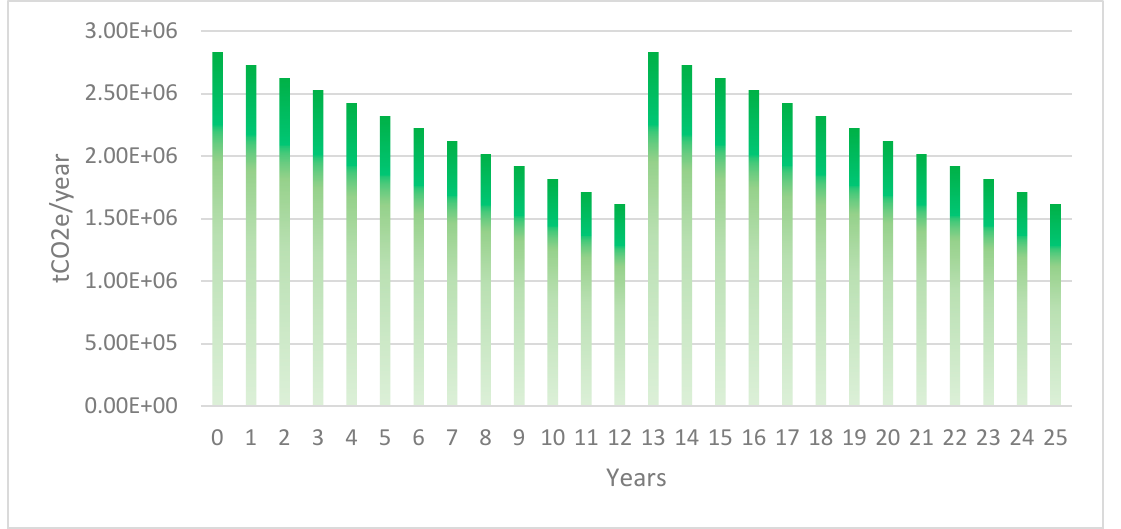
Figure 10. Avoided emissions over the lifespan of the project as tons of CO 2 per year.